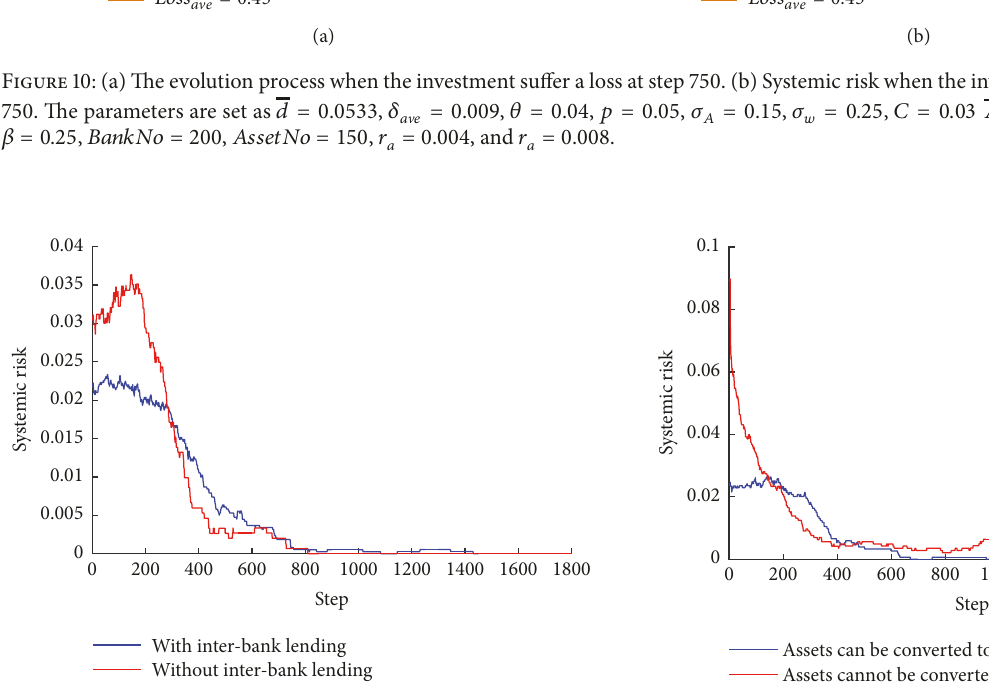
Figure 12: The evolution process of the system when the assets cannot be converted to debt repayment. The parameters are set as = 0.15 , 𝑑 = 0.0533 , 𝛿 = 0.009 , 𝜃 = 0.04 , 𝑝 = 0.05 , 𝜎 = 0.15 , 𝜎 = 0.25 , 𝐴 𝑎 V e 𝐴 𝑤 𝐶 = 0.03 𝐴 = 1000 , 𝑤 = 500 , 𝜒 = 0.3 , 𝛽 = 0.25 , 𝐵𝑎𝑛𝑘𝑁𝑜 = 200 , = 0.004 , and 𝑟 = 0.008 𝐴𝑠𝑠𝑒𝑡𝑁𝑜 = 150 , 𝑟 𝑎 𝑎